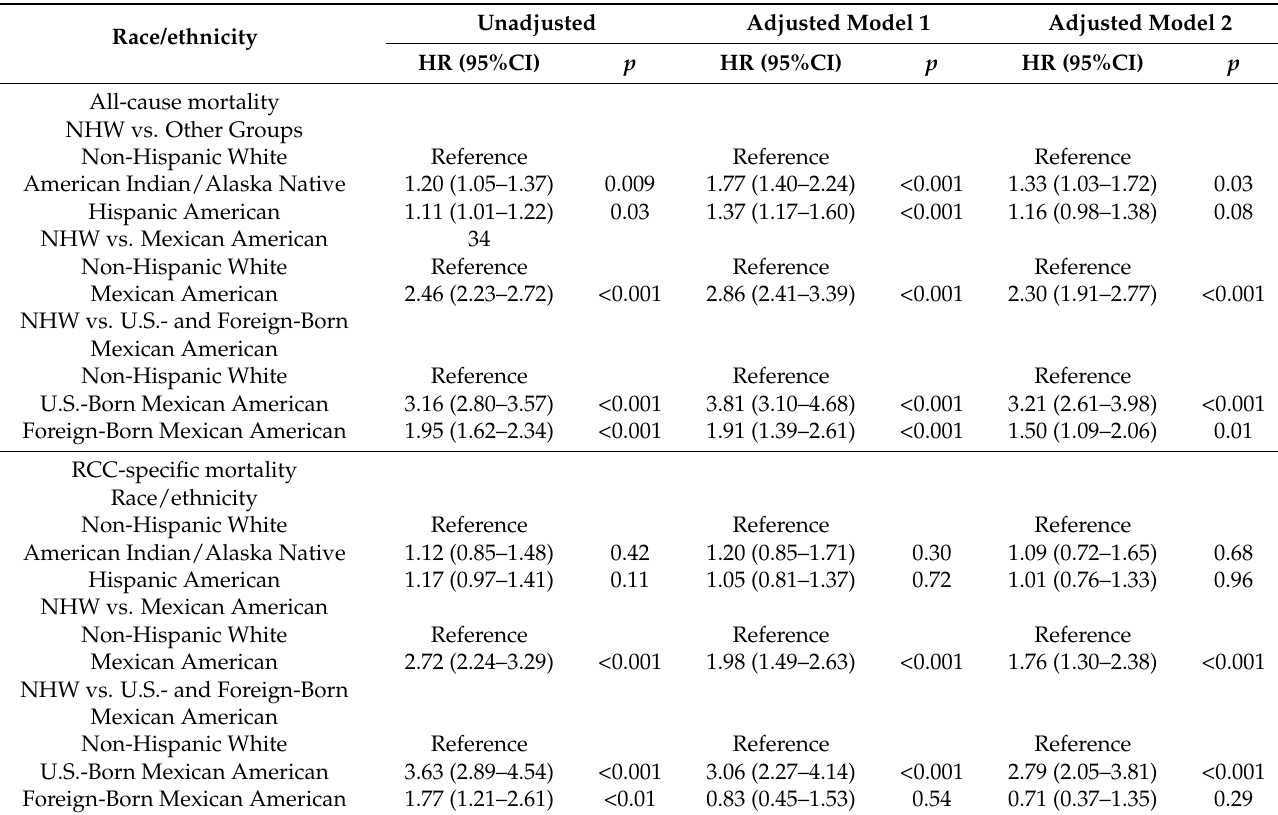
Table 3. All-cause and RCC-specific mortality in